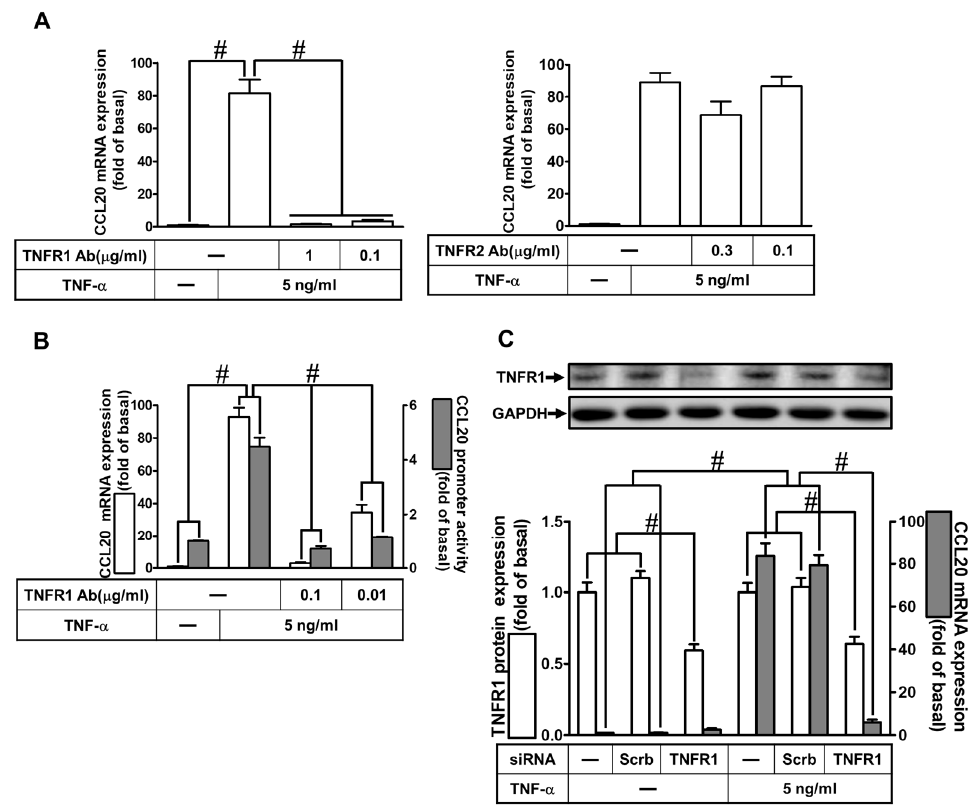
Figure 2. TNF- α -induced CCL20 expression via TNFR1 in HCFs. ( A ) Cells were pretreated with 1 and 0.1 μ g/mL TNF receptor 1 antibody (TNFR1 Ab) or TNFR2 Ab for 1 h, and then incubated with